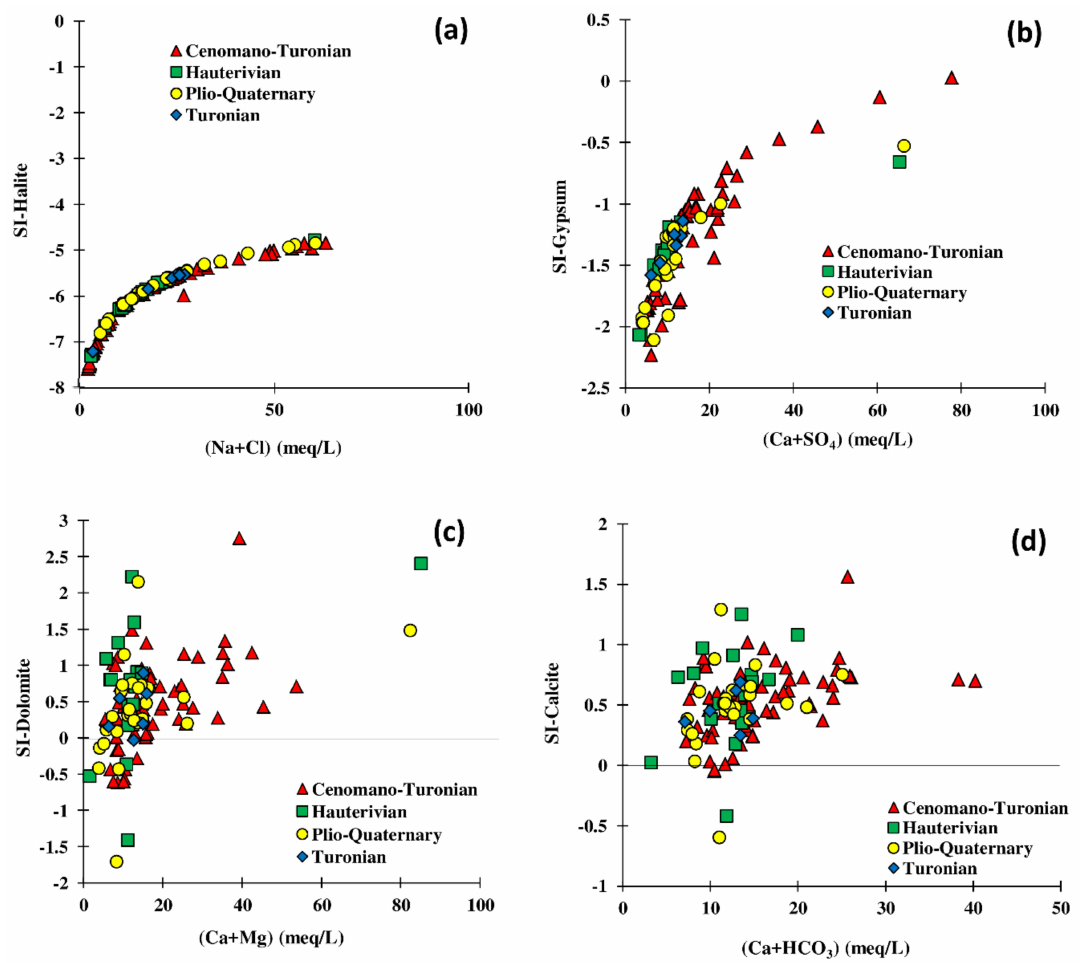
Figure 15. Correlation diagrams: ( a ) SI-halite vs. Na + + Cl − , ( b ) SI-gypsum vs. Ca 2+ + SO 42 − , ( c ) SI-dolomite vs. Ca 2+ + Mg 2+ , and ( d ) SI-calcite vs. Ca 2+ + HCO 3 − . SI: Saturation index, (campaign of